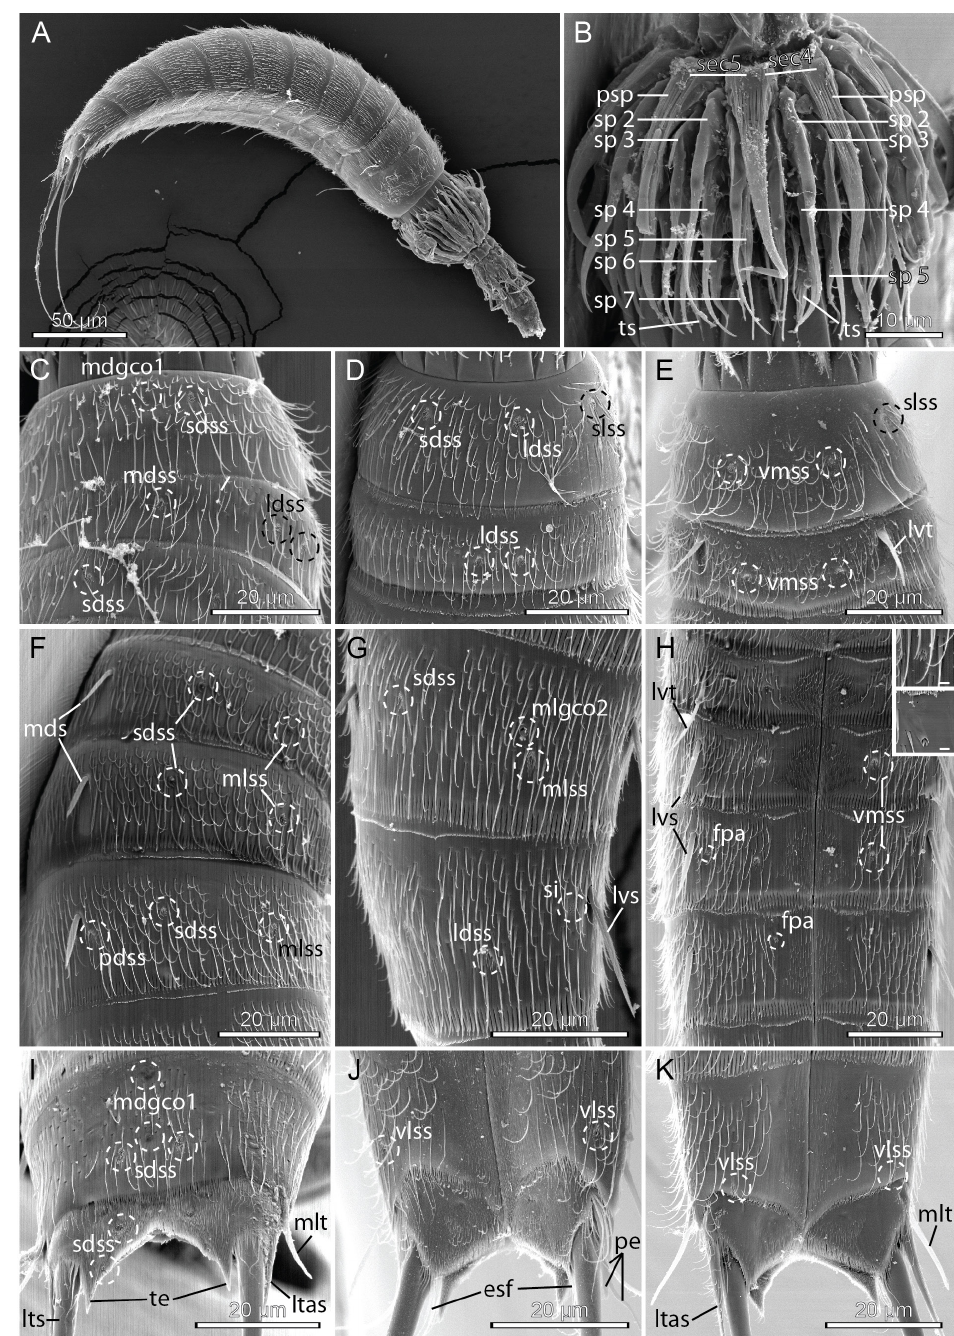
Fig. 21. Scanning electron micrographs showing overviews and details of Echinoderes songae Sørensen & Chang sp. nov. A–B, D, F–I, K . ♀ (MVS, personal reference collection). C, E, J . ♂ (MVS, personal reference collection). A . Lateroventral overview. B . Introvert sectors 5 and 4 (laterodorsal). C . Segments 1 to 3, dorsal view. D . Segments 1 to 2, laterodorsal view. E . Segments 1 to 2, ventral view. F . Segments 4 to 6, laterodorsal view. G . Segments 8 to 9, lateral view; inset show glandular cell outlets type 2. H . Segments 5 to 8, ventral view, showing female sexual dimorphism; insets show outlets of female papillae on segment 7 (upper inset) and segment 8 (lower inset), scale on insets = 1 µm. I . Segments 10 to 11, dorsal view, showing female sexual dimorphism. J . Segments 10 to 11 ventral view, showing male sexual dimorphism. K . Segments 10 to 11 ventral view, showing female sexual